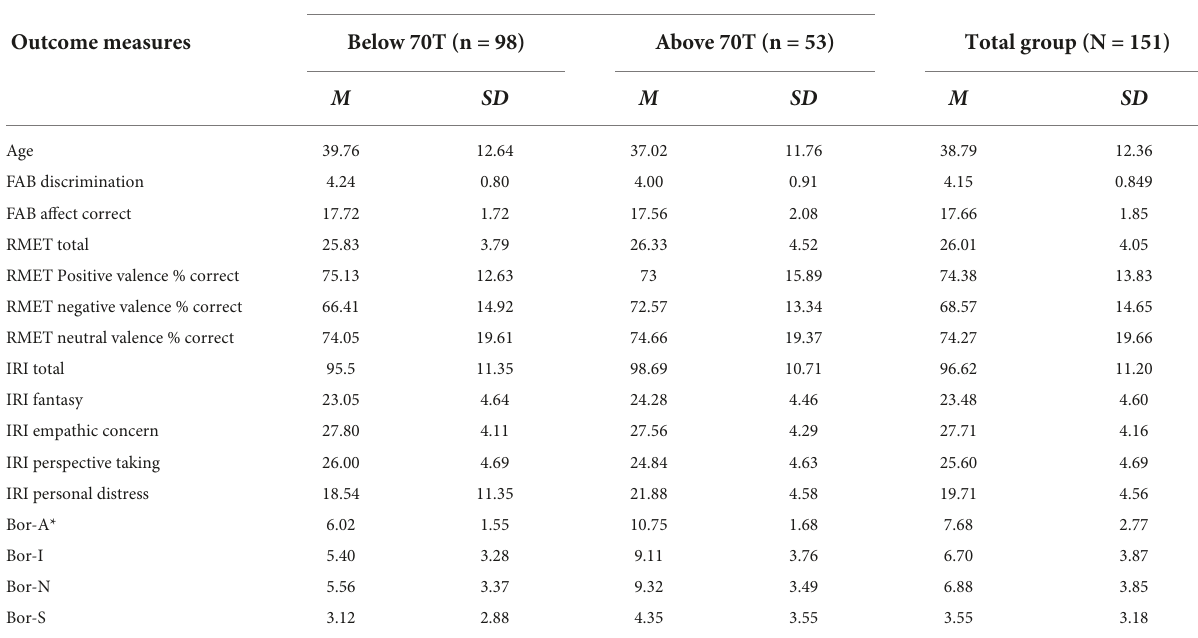
TABLE 2 Means (M) and Standard Deviations (SD) on outcome measures for the total group, and stratified by Bor-A